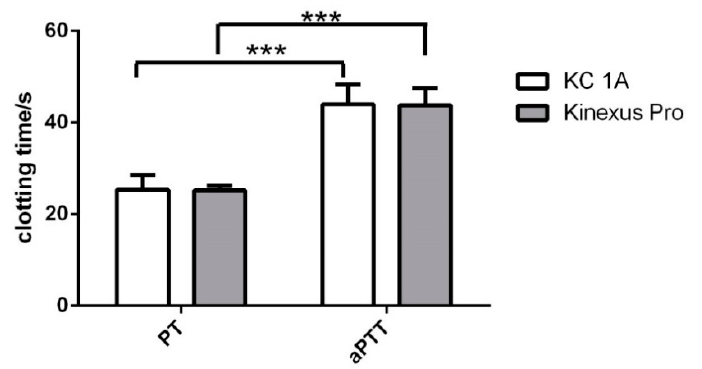
Figure A5. Comparison between PT and aPTT, respectively, measured with Kinexus Pro and KC 1A ( n = 10). The asterics above the bars indicate that this particular bar is significantly different from all others. The clotting times (CT) determined with either Kinexus or the ball coagulometer were not significantly different within one assay but significantly longer for aPTT measurements in both devices. *** p < 0.001.